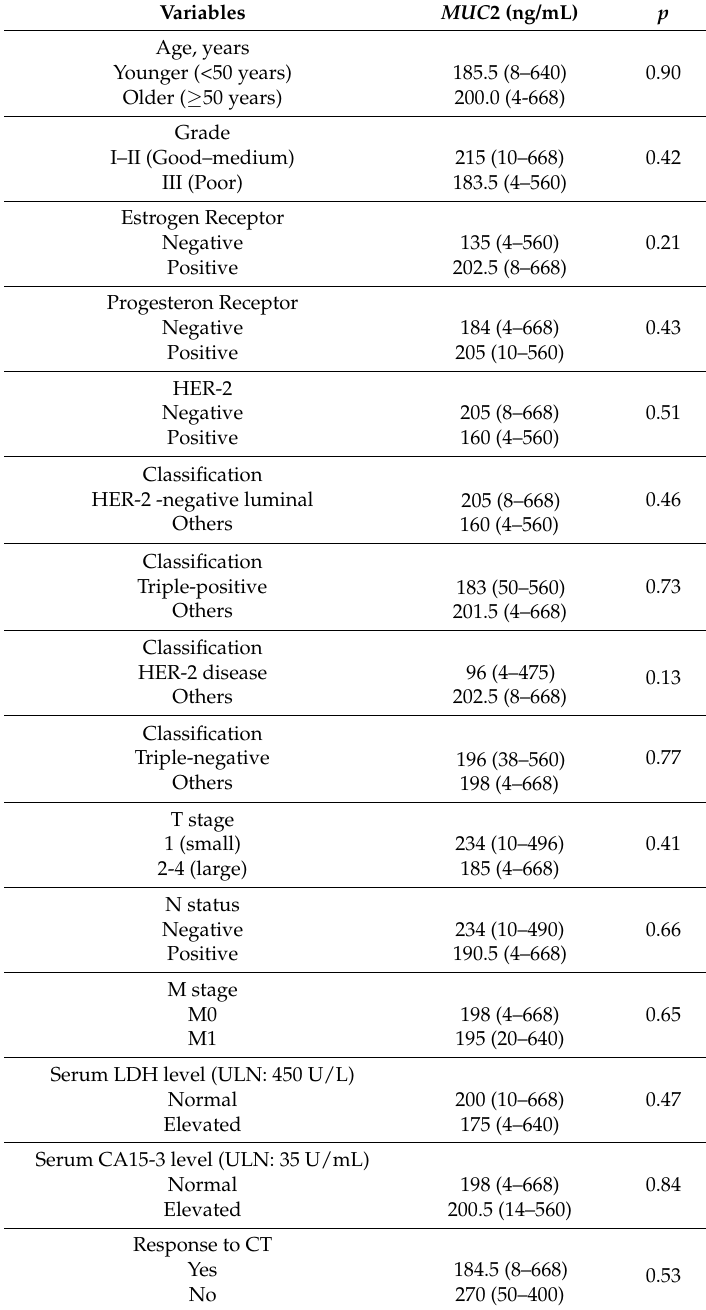
Table 3. Results (median and range) of comparisons between the factors and various clinical/laboratory